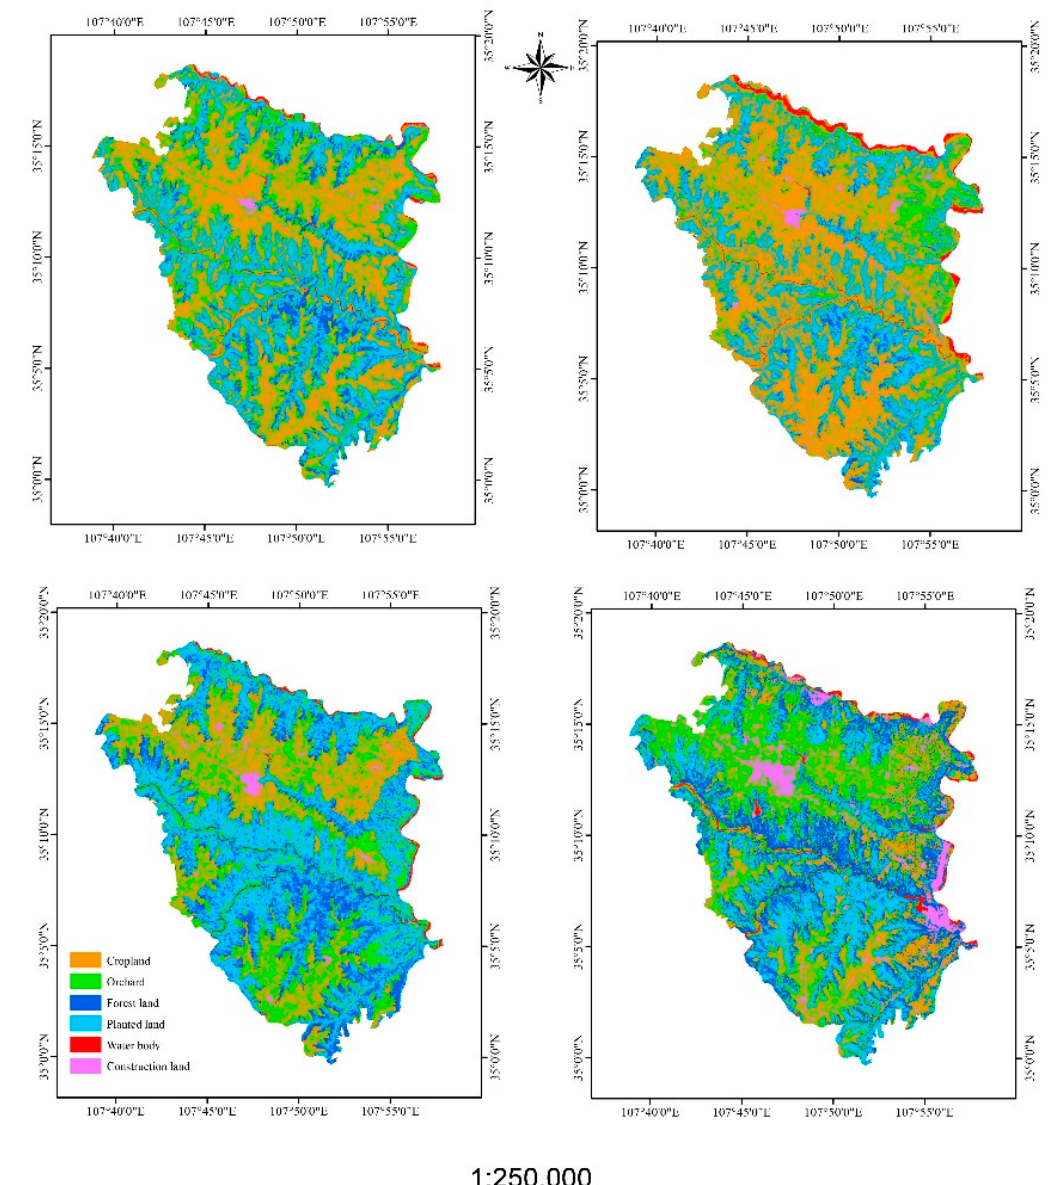
Figure 2. The land use/cover maps for 1987, 1997, 2007, and 2017.